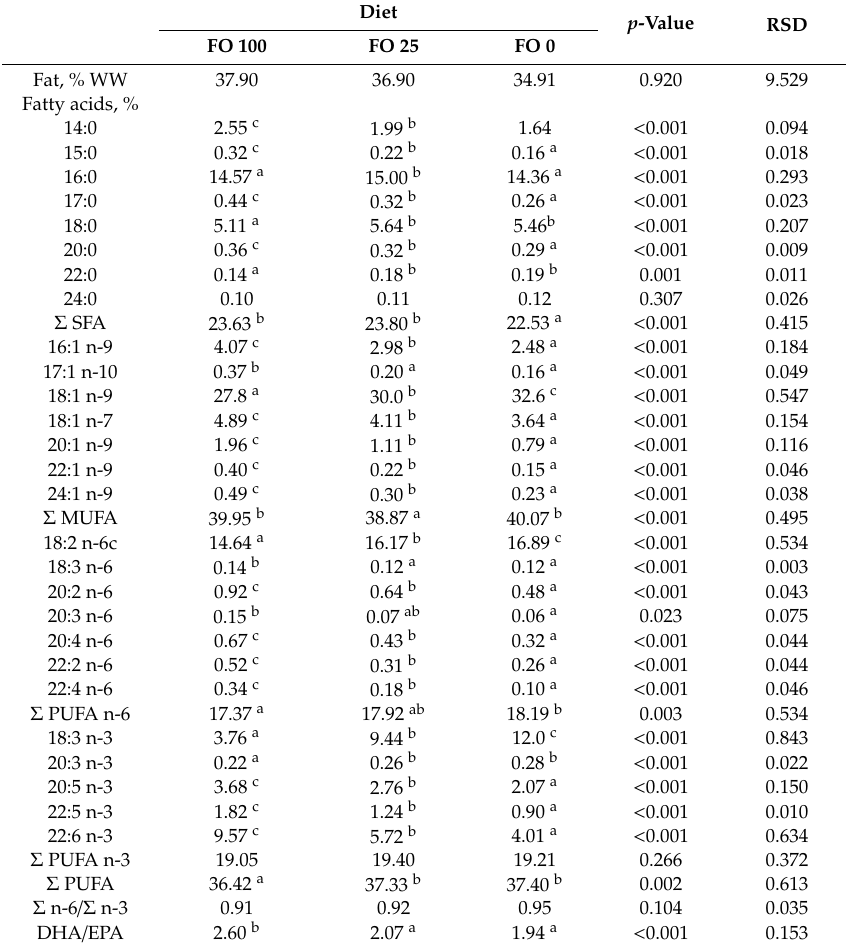
Table 5. Fat content and fatty acid composition (% of total fatty acid content) of the visceral fat in Mediterranean yellowtails fed the experimental diets ( n = 12 per diet). Values are expressed as LS means.